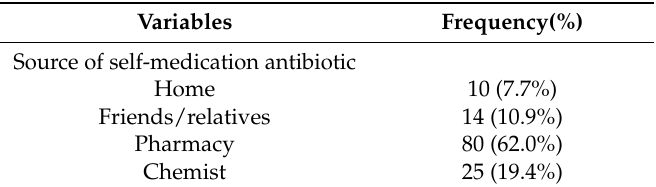
Table 2. The main sources of self-medication.